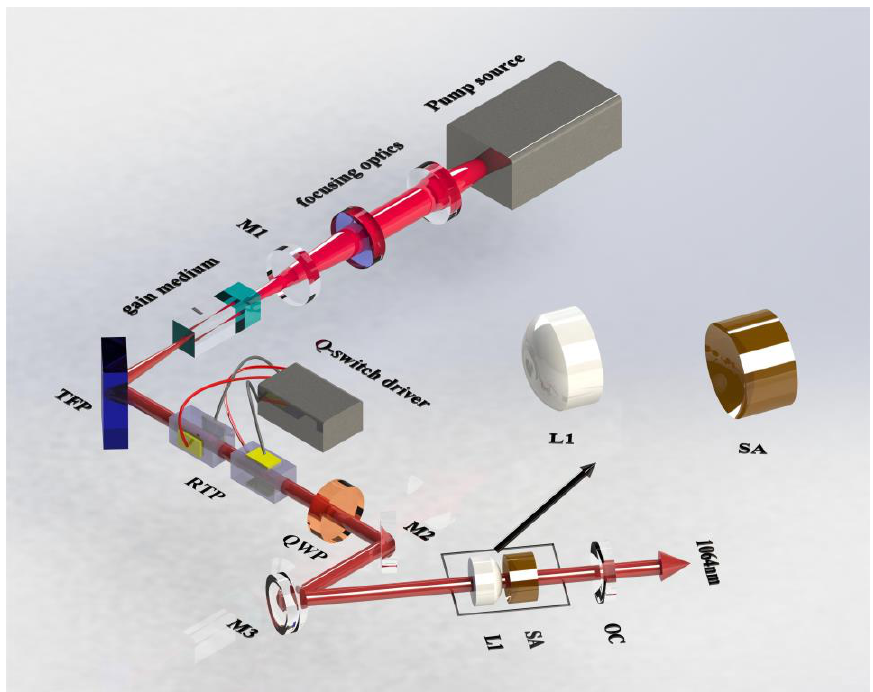
Figure 1. Schematic of the 1.06 μm hybrid Q-switched laser. (TFP: thin film polarizer, RTP: Rubidium titanate phosphate crystal, QWP: quarter-wave plate, SA: saturated absorber, OC: output coupler).